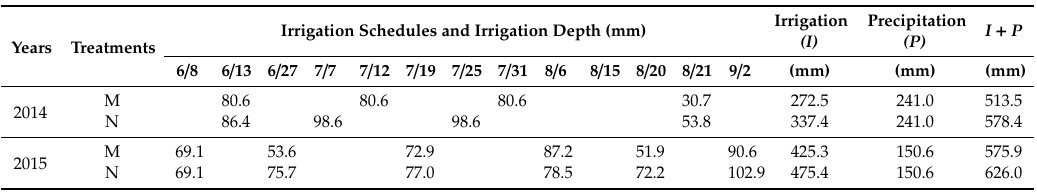
Table 1. Irrigation schedules for treatments with and without plastic film mulch (M and N) and precipitation during the growth season of seed maize in 2014 and 2015.